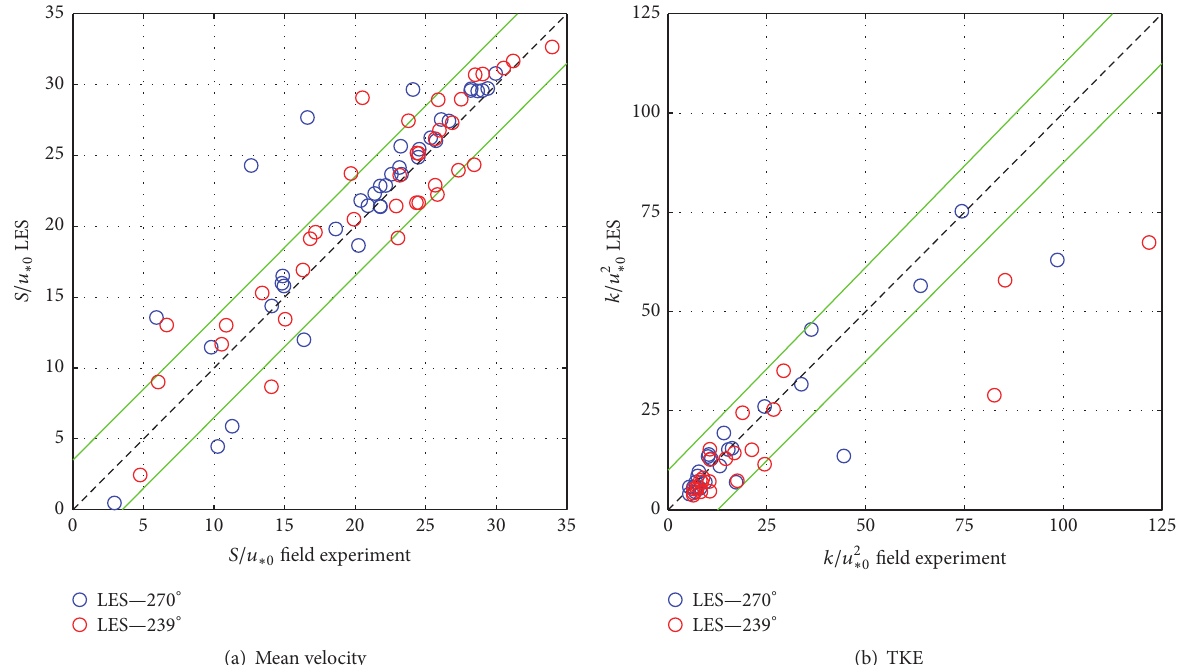
Figure 6: Scatter plots of field data against LES results; solid lines: interval of ±10 % around perfect fitting (dashed line).